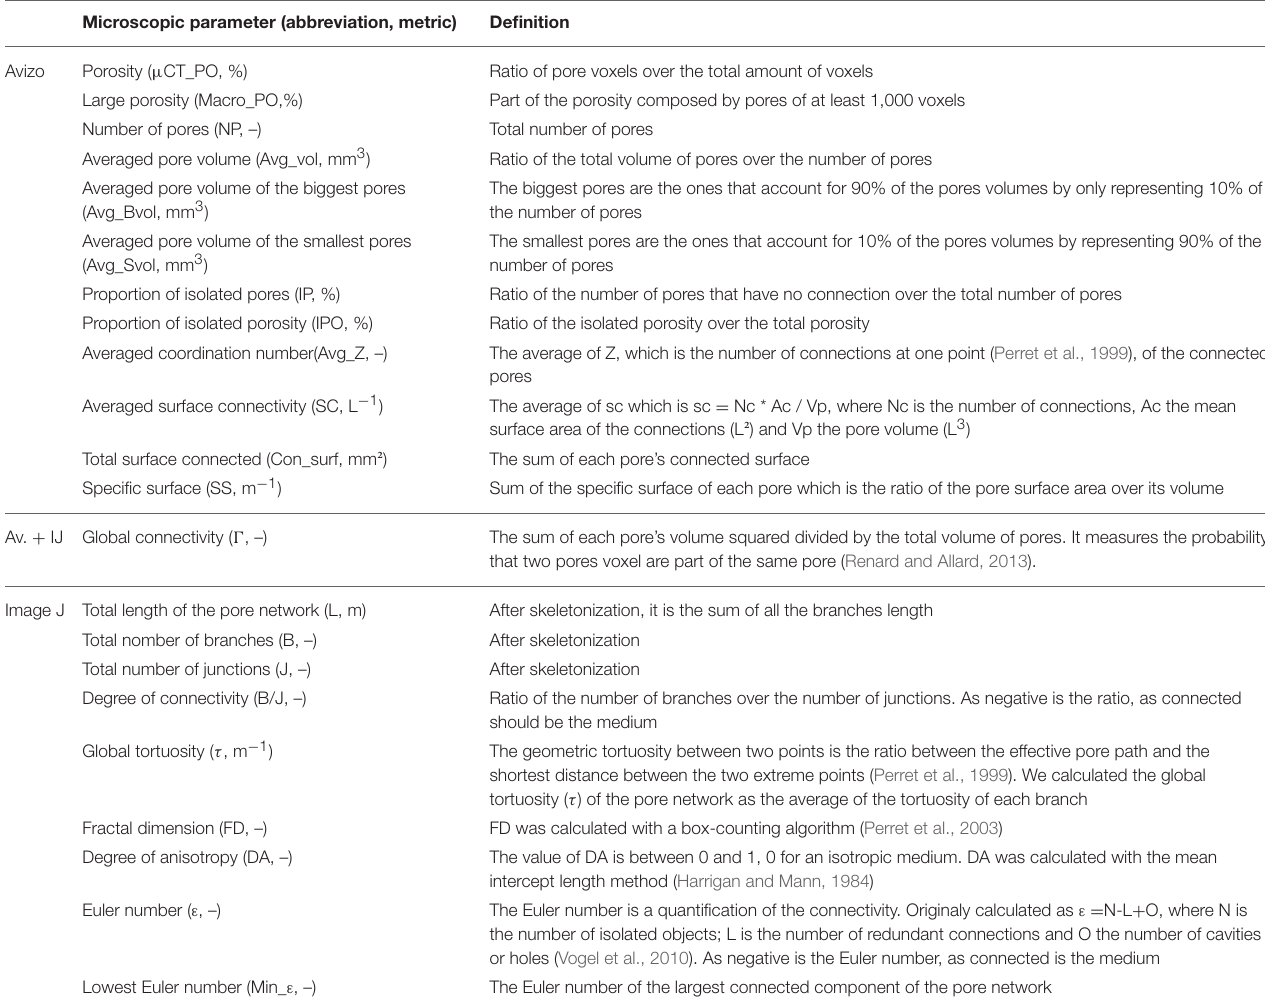
TABLE 1 | Calculated microscopic parameters on the X-ray µ CT images and their definition. Microscopic parameter (abbreviation,